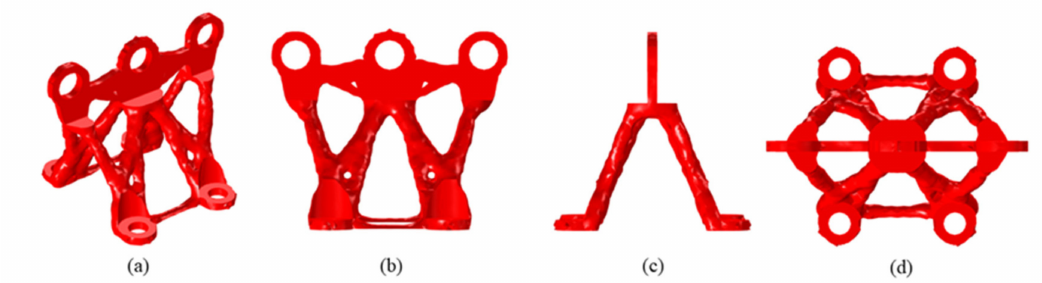
Figure 9. ( a ) Represents the isometric view of the result; ( b ) represents the front view of the result; ( c ) represents the side view of result; ( d ) represents the top view of the